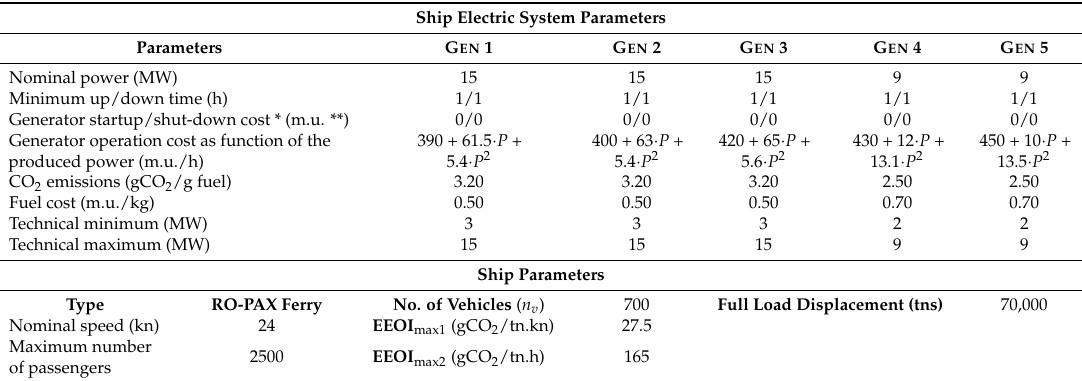
Table 1. Ship power system data and ship parameters.